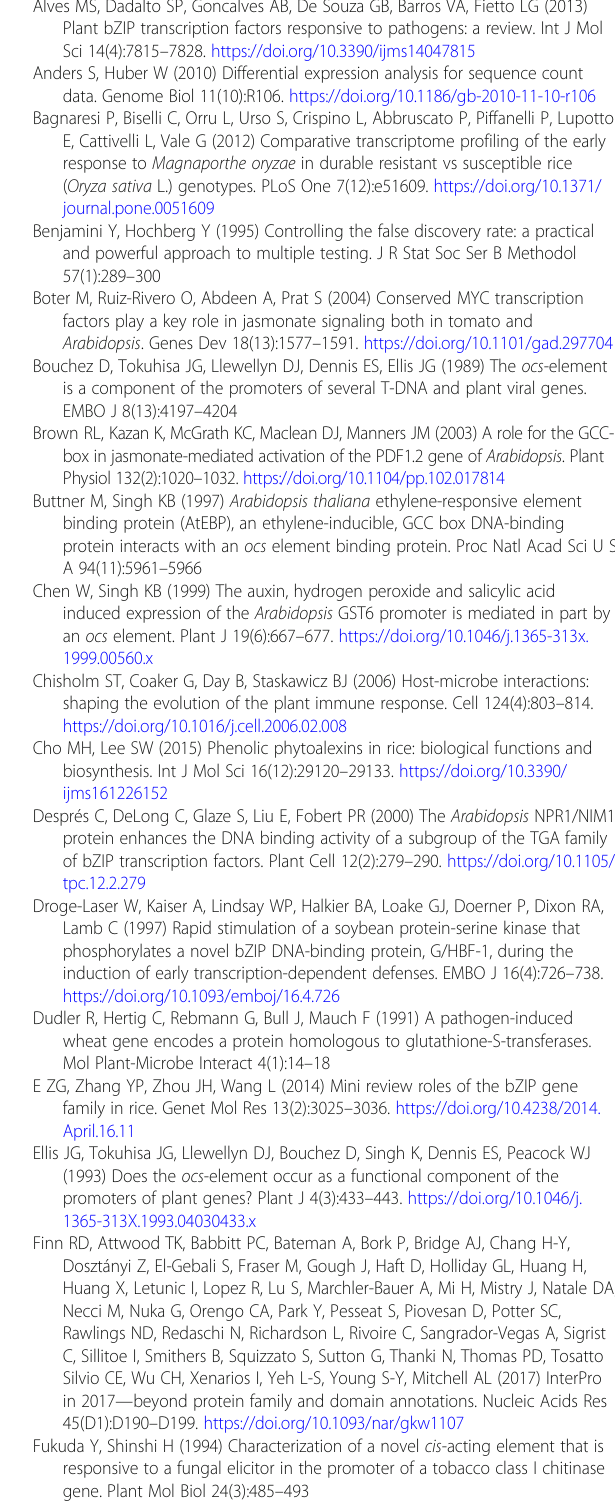
Additional file 8: Table S7. Differentially expressed transcripts in common from the rice microarray and RNA-Seq data analyses. (XLSX 21 kb) Additional file 9: Figure S2. The upstream sequences and putative pathogen-inducible cis -elements (PICEs) in rice. This document-like figure contains 212 upstream sequences (2000 bp) that correspond to the 212 differentially expressed transcripts obtained from the microarray and mRNA-Seq data analyses. The PICEs (AS-1, G-box, GCC-box and H-box) are highlighted in yellow. W-box, GT1, ERE (elicitor-responsive element) and MRE cis -elements are highlighted in green, cyan, magenta and red, respectively. (DOCX 165 kb) Additional file 10: Table S8. Differentially expressed genes without the PICEs in the promoters identified from the rice microarray data Additional file 11: Table S9. Differentially expressed genes without the PICEs in the promoters identified from the rice RNA-Seq data Additional file 12: Table S10. The proportion of the differentially expressed genes in the total rice genes. (XLSX 12 kb) Additional file 13: Table S11. The enrichment analysis of the differentially expressed rice genes driven by PIPs through Fisher ’ s exact test comparing each pair of the proportions of the differentially expressed genes in the total genes from Additional file 8: Table S10. (XLSX 11 kb)